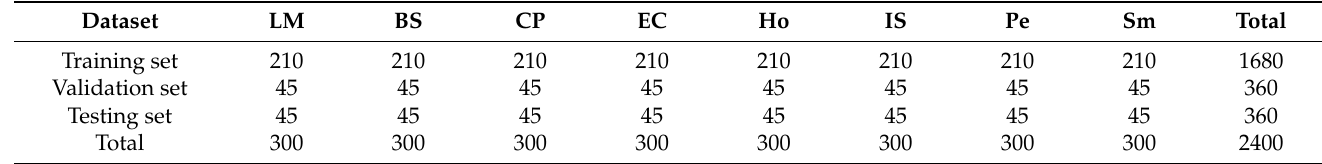
Figure 2. Surface defect dataset of copper strip (YSU_CSC). Table 3. Distribution of surface defect images in the training, validation, and testing sets.